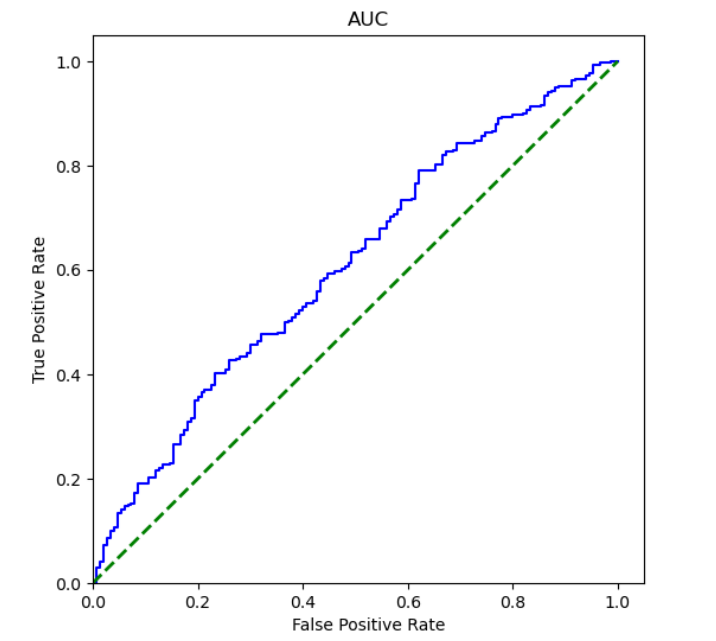
Figure 14. ROC curve of